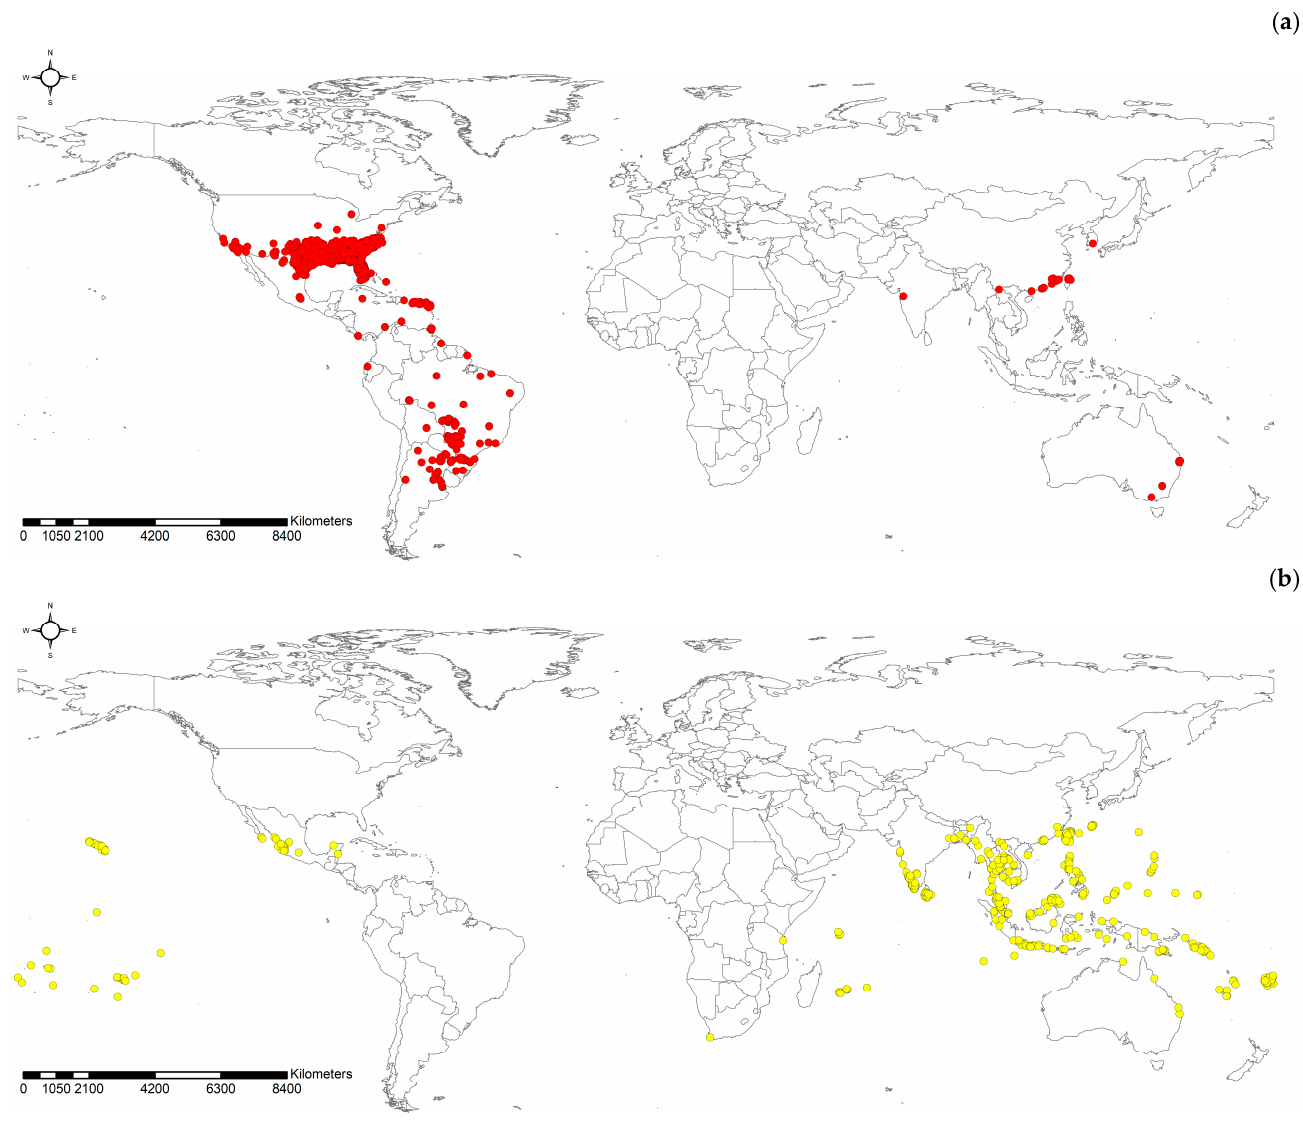
Figure 1. Global coordinating of occurrence data of ( a ) Solenopsis invicta (red dots) and ( b ) Anoplolepis gracilipes (yellow dots) .